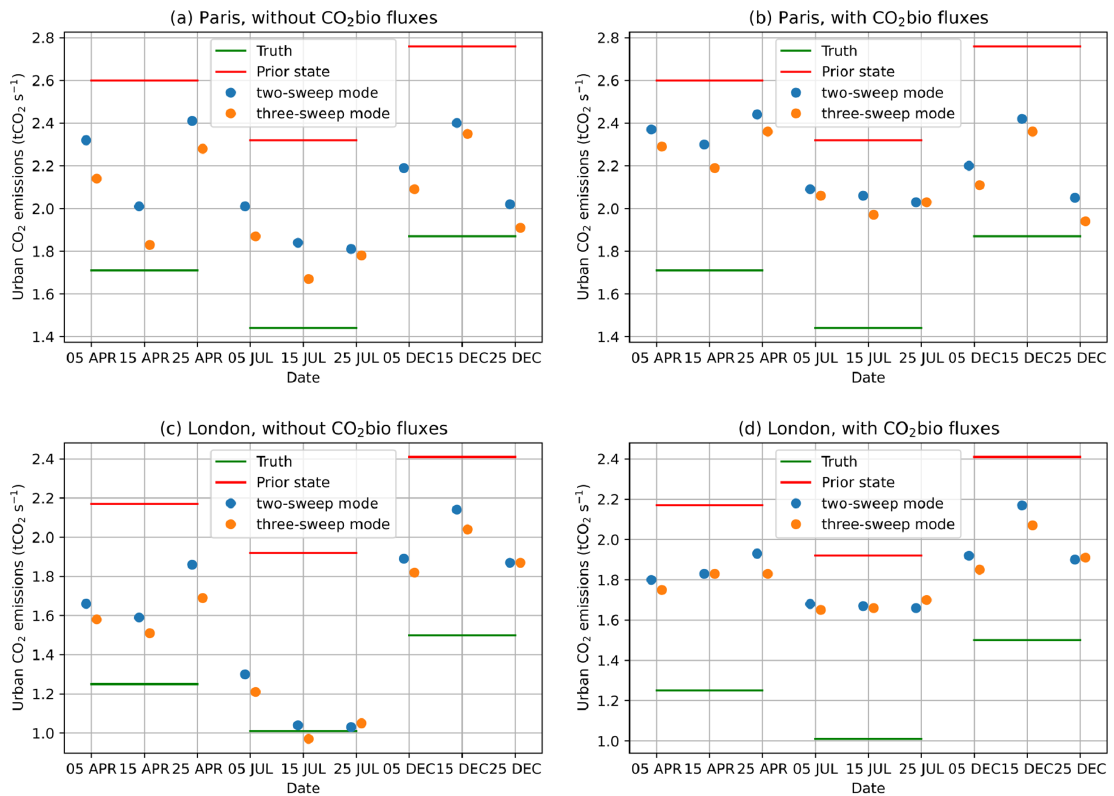
Figure 8. Total fossil fuel CO 2 emissions within the domain in Paris (a, b) and London (c, d) for different sampling scenarios. Panels (a) and (c) do not include the biogenic CO 2 flux component, while panels (b) and (d) include the biogenic